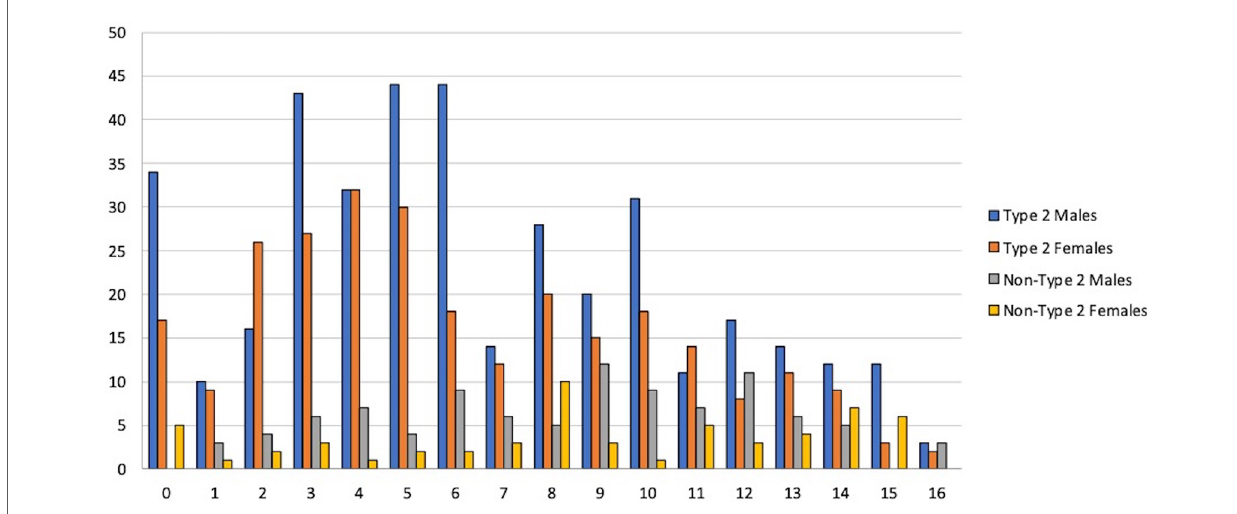
FIGURE 1 Snif fi n ’ Sticks Identi fi cation Test: distribution of total scores in male and females in both type 2 and non-type 2 groups. Patients were enrolled in 21 different Hospital Centers in Italy: 109 in Varese, 101 patients in Bologna (AUSL), 73 in Genova, 67 in Milano (Ospedale San Paolo), 62 in Rome (Policlinico Gemelli), 51 in San Vito al Tagliamento, 49 in Catania, 43 in Napoli (University Federico II), 39 in Pisa, 30 in Milano (Humanitas Hospital), 25 in Padova, 21 in Catanzaro, 20 in Bologna (Policlinico Sant ’ Orsola), 20 in Cremona, 20 in Palermo, 20 in Pavia, 16 in Milano (Ospedale Niguarda), 14 in Parma, 13 in Bolzano, 10 in Barletta, and 8 in Treviso.